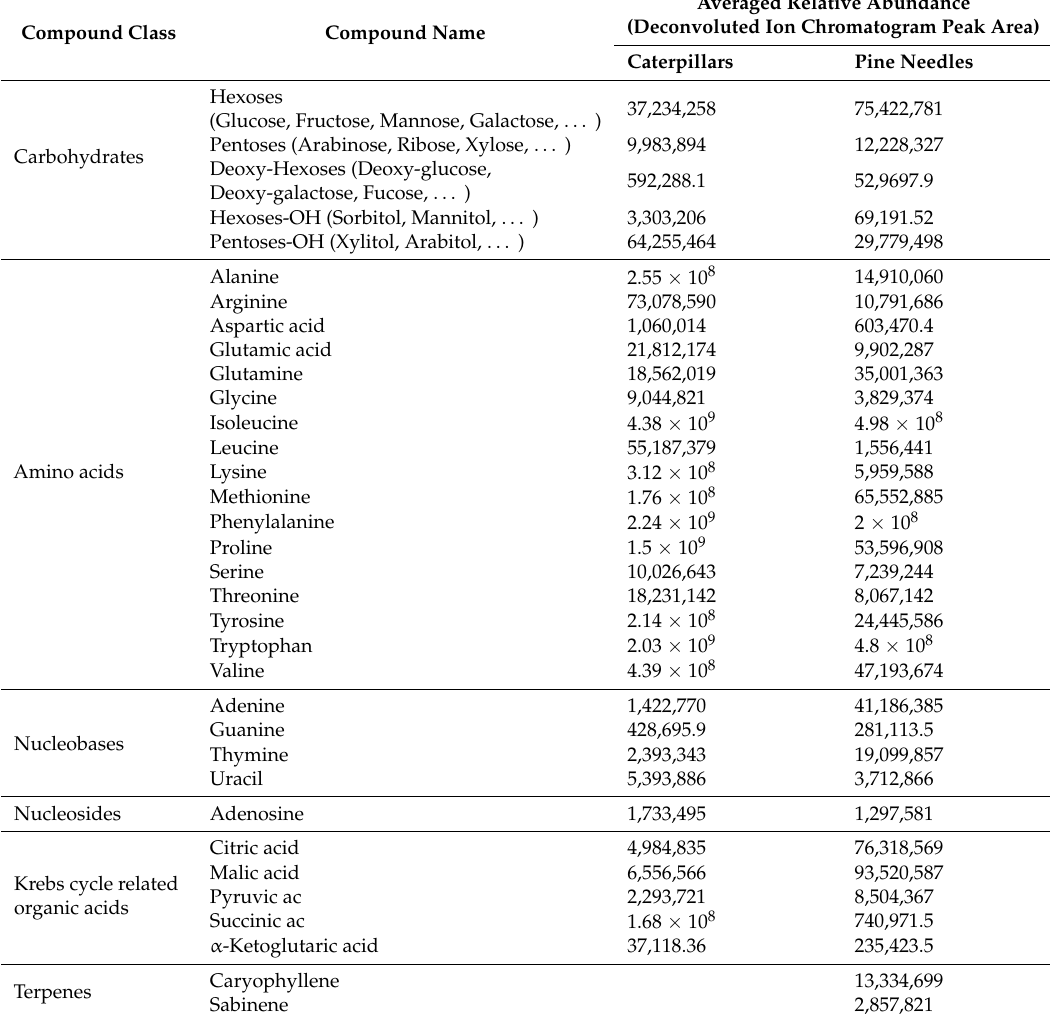
Table 1. Identified molecular compounds in caterpillar tissues and pine needles by liquid chromatography coupled to mass spectrometry